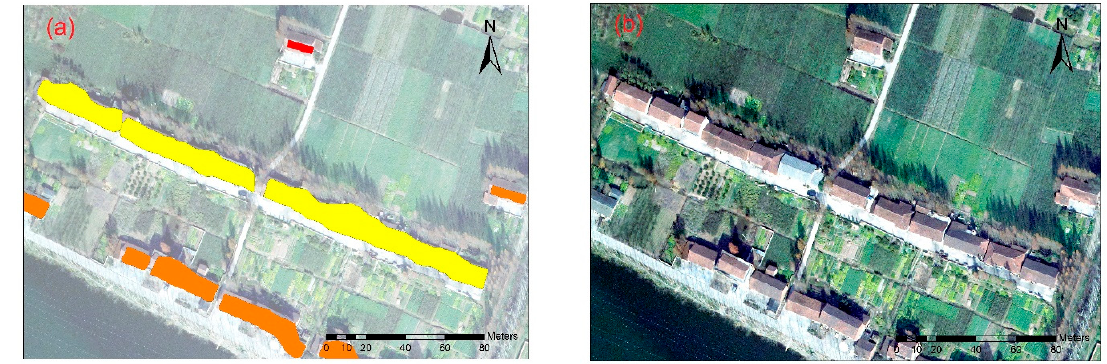
Figure 14. Example of adjoining buildings. ( a ) is vector data of buildings and ( b ) is remote sensing image of buildings.